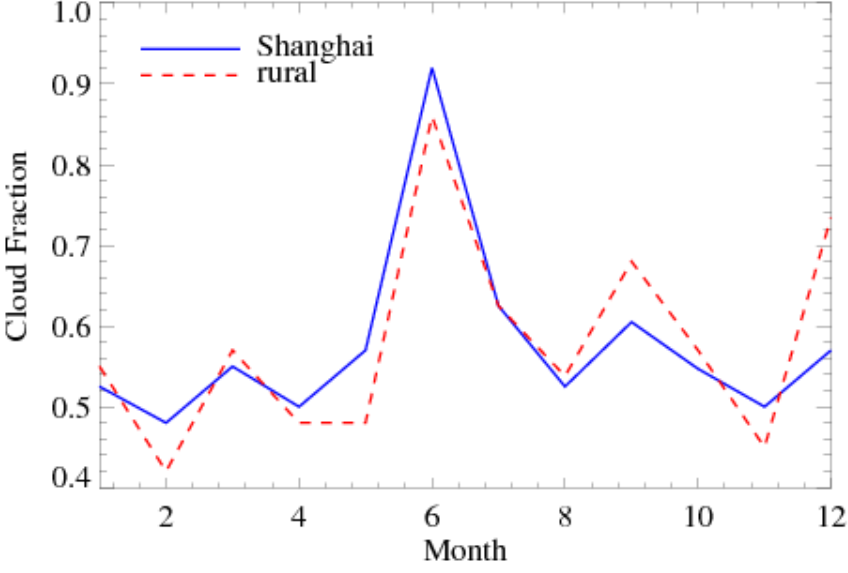
Figure 12. Multi-year averaged (2000–2008) cloud fraction for Shanghai and rural regions. Shanghai minus rural. Data is from monthly MODIS observations at 10:30